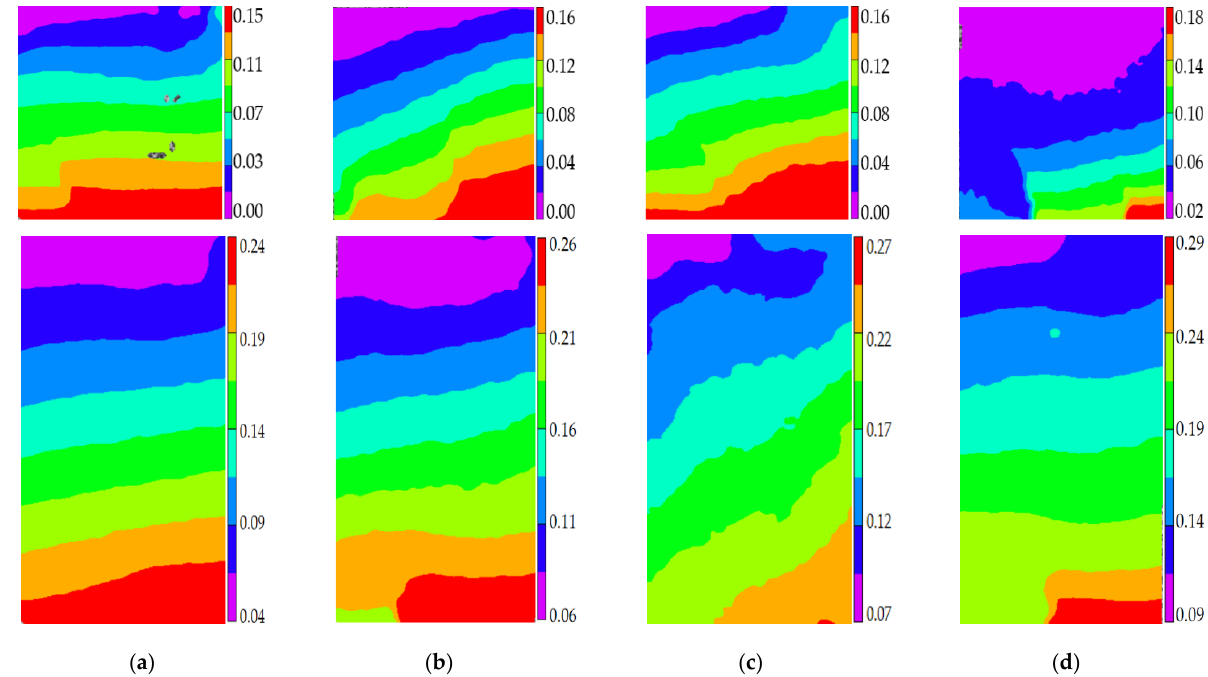
Figure 12. The horizontal strain cloud diagram of concrete with different coarse aggregate volume fraction at the turning point of damage stage I, ( a ) 9.5 mm, ( b ) 19 mm, ( c ) 26.5 mm, ( d ) 31.5 mm.